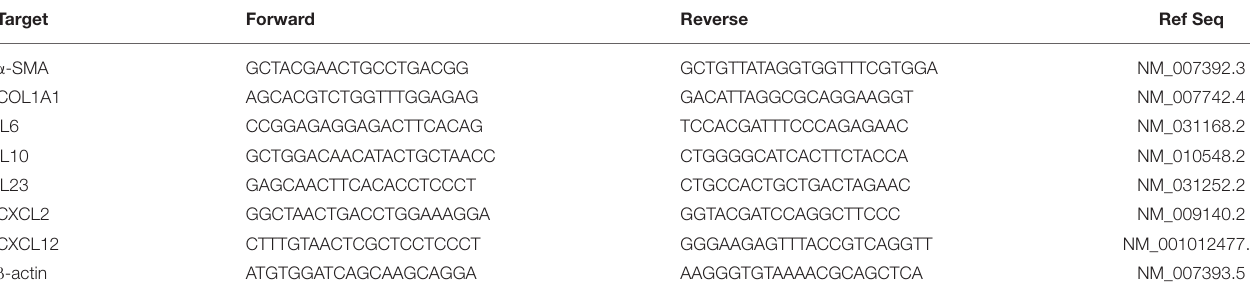
TABLE 4 | Primers for qRT-PCR analysis on murine liver tissues.